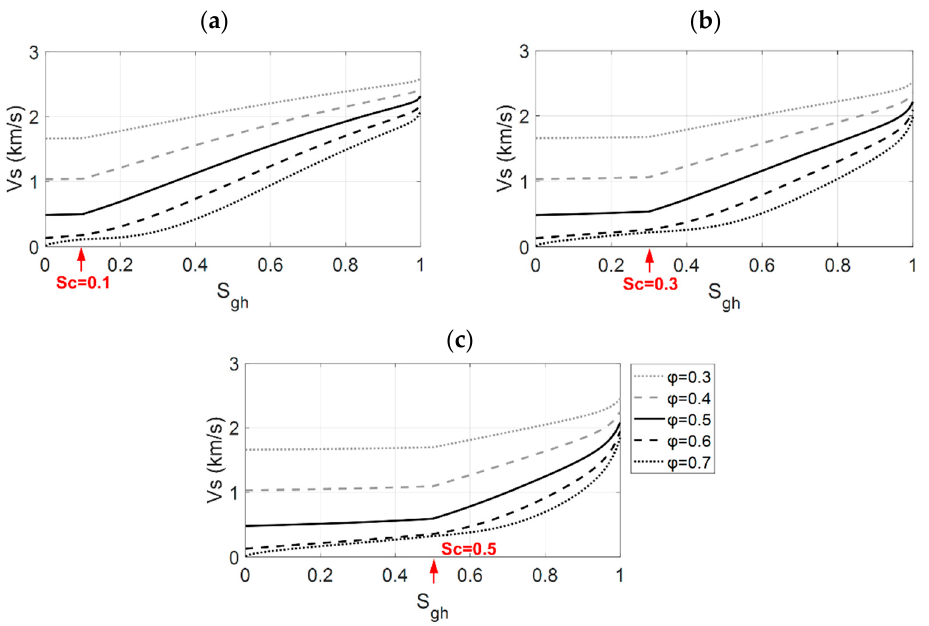
Figure 5. The computed S-wave velocity ( V S ) in terms of the gas hydrate saturation ( S gh ) with varying porosity for three levels of the critical gas hydrate saturation ( Sc ): ( a ) 0.1, ( b ) 0.3, and ( c ) 0.5.